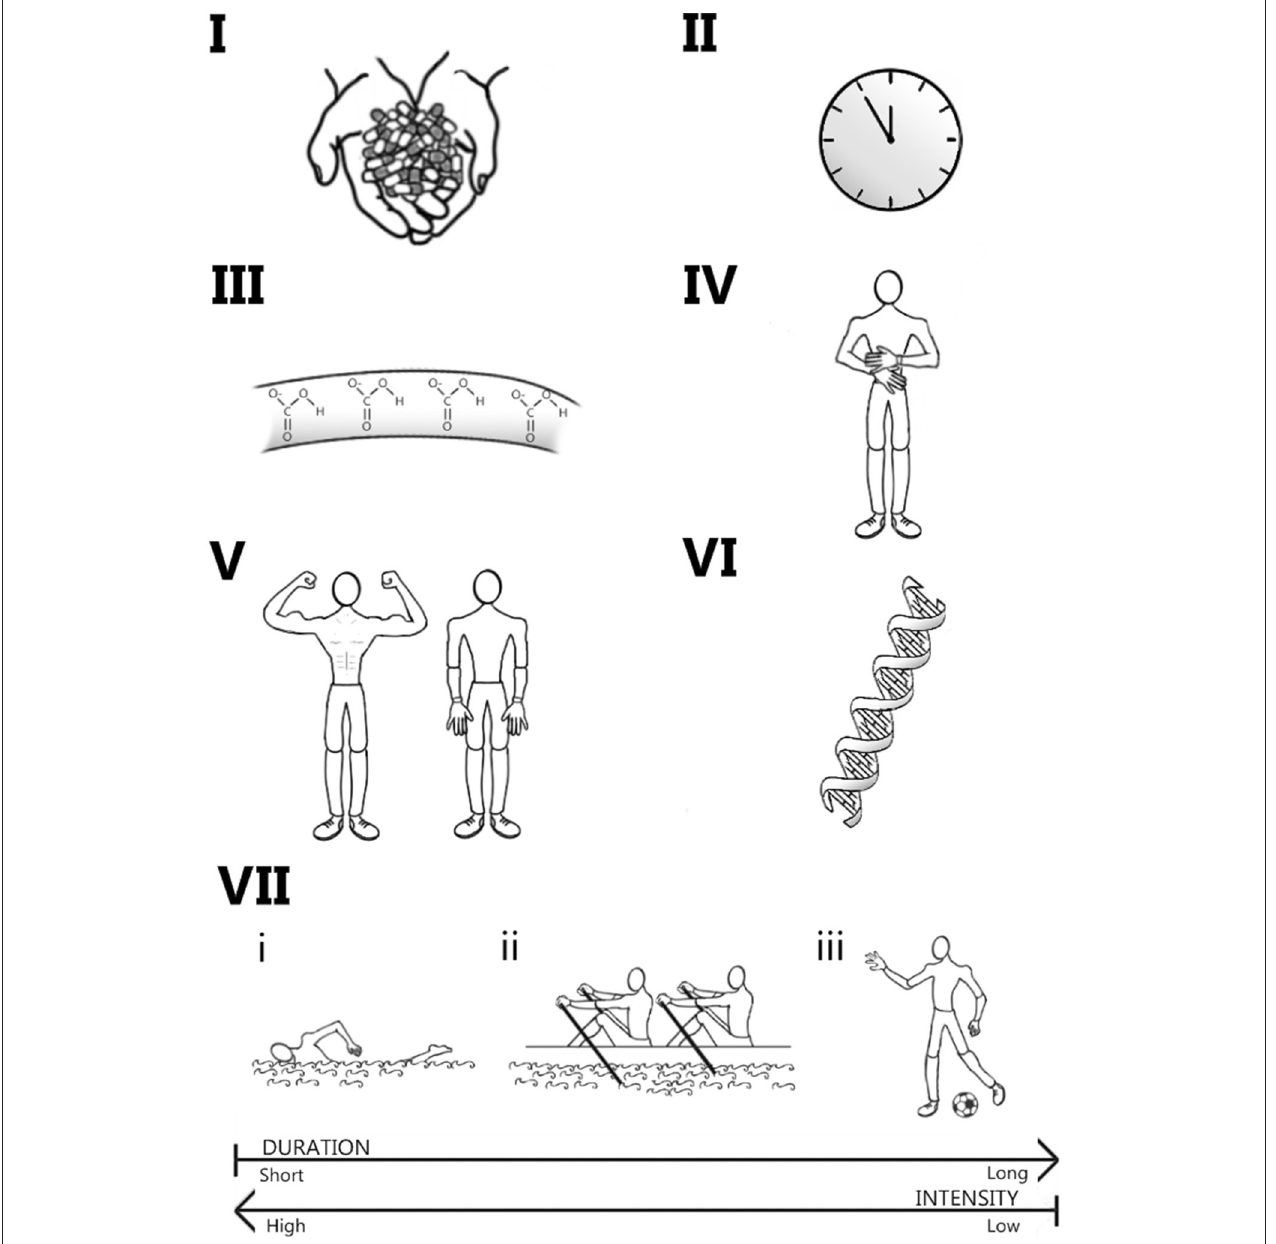
FIGURE 4 | Overview of the factors which may modify the response to supplementation with sodium bicarbonate, sodium citrate, and calcium and sodium lactate. The dose (Panel I) and timing of ingestion (Panel II) can influence both the increases in circulating bicarbonate (Panel III) and associated side-effects (Panel IV) at the moment of exercise, impacting upon the likelihood of a performance benefit. Training status (Panel V) and genetic make-up (Panel VI) of the individual may further modify this response. The chances of a positive response may also be modified by the duration and intensity of the exercise task being performed (Panel VII): short-duration continuous exercise, such as 100 and 200m swimming (i) and 2,000m rowing (ii), and prolonged intermittent activity, such as football (iii), may be particularly susceptible to improvements with these supplements.